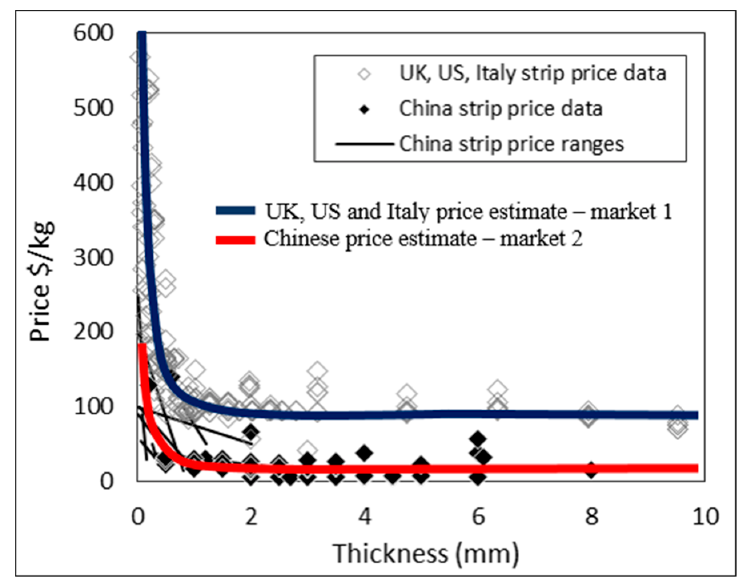
Figure 14. Middle price estimates for grades 1–4 titanium strip for the UK, US, and Italy versus China. Data is only for strip widths >120 mm and <660 mm, and lengths of 500 mm or more.